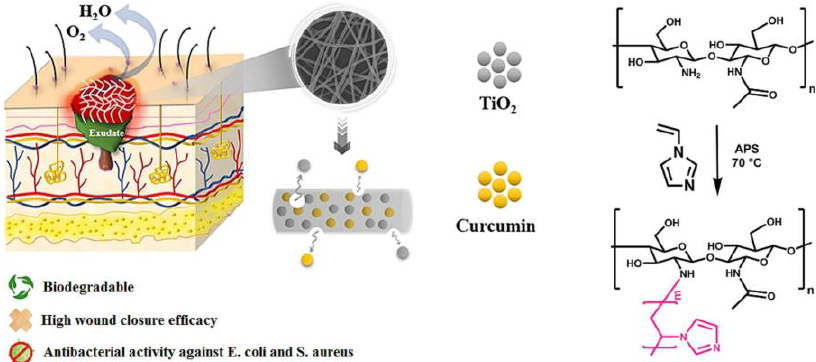
Figure 3. Electrospun Poly(vinyl alcohol)/Chitosan-g-Poly (N-vinyl imidazole) wound dressing containing titanium dioxide/curcumin showing faster wound healing through better drug release (reprinted with permission [55] from Elsevier).